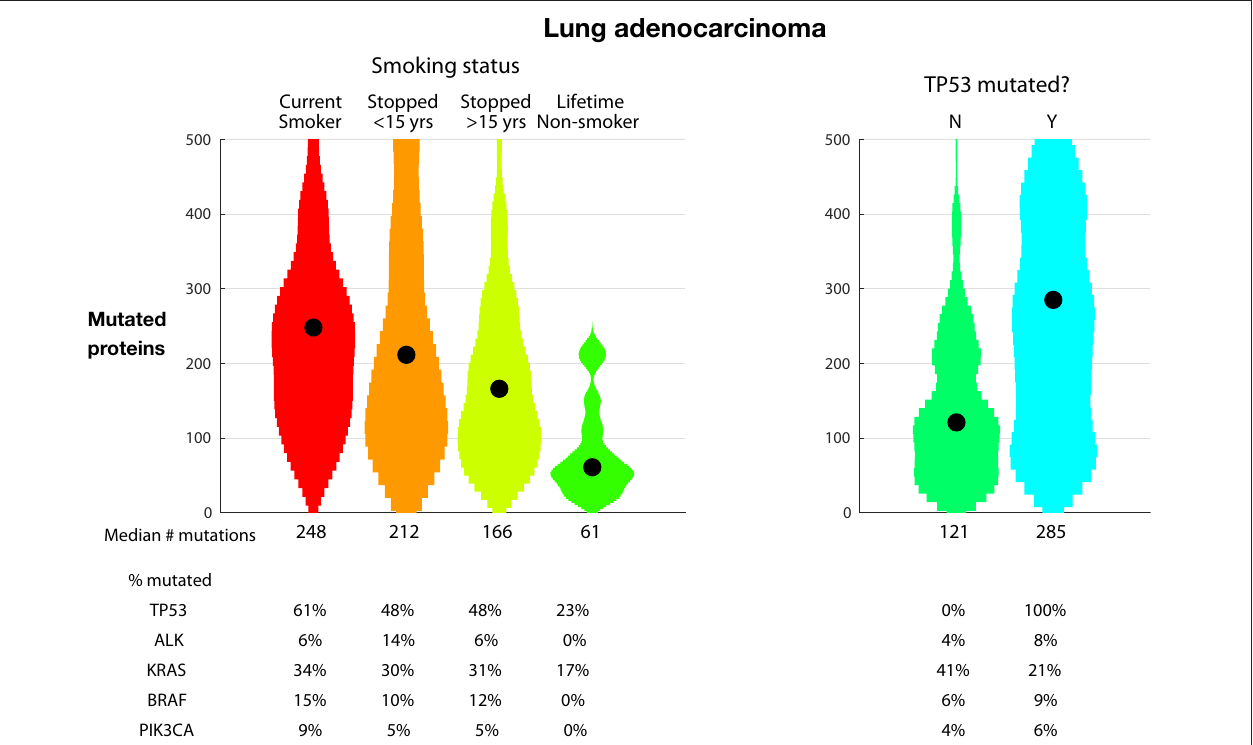
FIGURE 3 | Tumor mutational burden (TMB) in lung adenocarcinoma. Plots show distributions as violin plots with medians indicated as a point. (Left) TMB vs. smoking status. (Right) TMB vs. TP53 mutational status. TMB is defined as the number of proteins with a non-synonymous